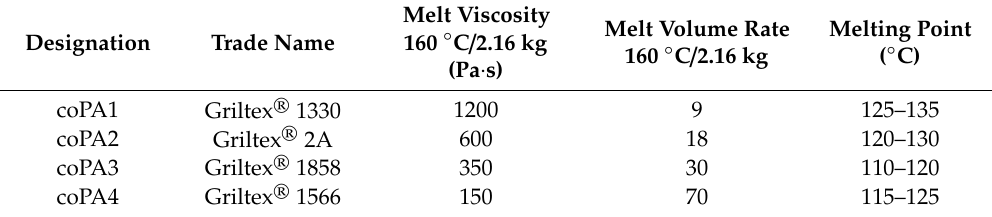
Table 1. Properties of thermoplastic copolyamides (coPAs) used in the